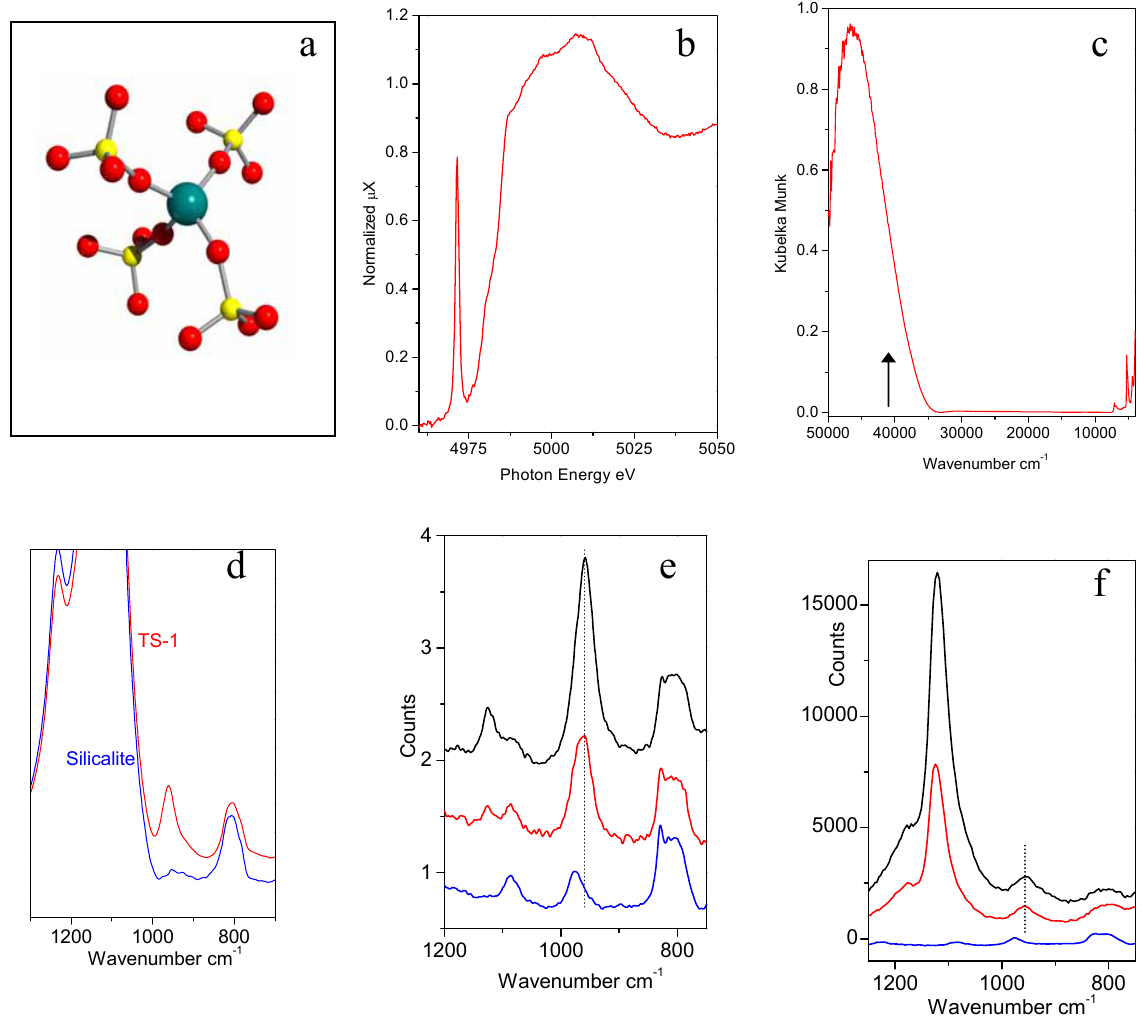
Figure 3: Part (a): schematic representation of the insertion of Ti in the Ti in the zeolitic [Ti(OSiO unit. Ti, Si and O atoms are represented by blue, yellow and red spheres respectively. Parts (b-f): XANES, UV-Vis, IR Raman and resonant Raman features typical of [Ti(OSiO black curves refers to Ti-free silicalite, and to TS-1 with 1.4 and 3.0 wt. % in TiO